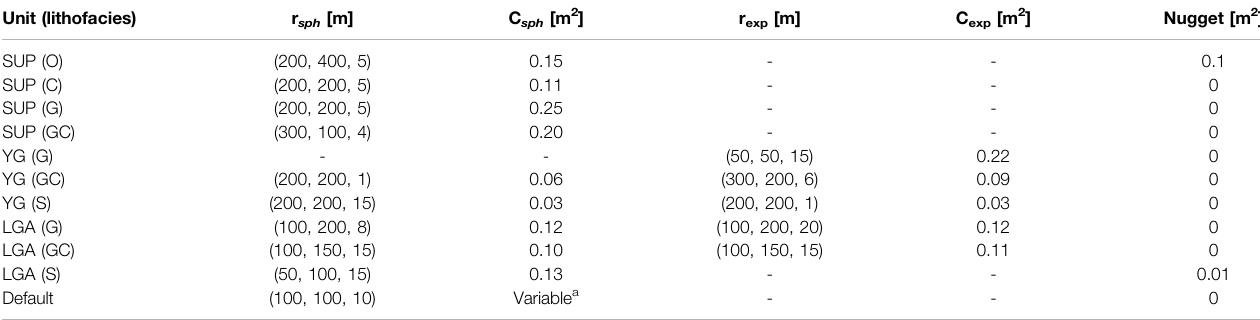
TABLE 3 | Covariance model parameters (C: contribution and r: ranges in x , y , and z directions) manually adjusted and used for the SIS of each unit. For units where the numberofdatapointswastoolow(LGLandLGT),adefaultmodelwastaken( “ Default ” row).Therangesaregiveninthethreemainaxisdirectionswithoutanyrotation( x axis goes toward E and y axis toward N). Subscripts exp and sph indicate exponential and spherical covariance models.